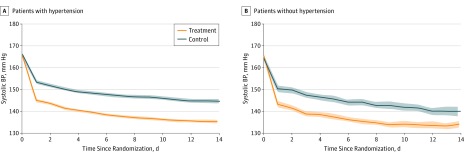
Systolic Blood Pressure (BP) Since Randomization by History of HypertensionA, Numbers at risk at entry were 1610 for the treatment group and 1599 for the control group. B, Numbers at risk at entry were 428 for the treatment group and 434 for the control group. Solid lines indicate mean BP; shading, 95% CI.